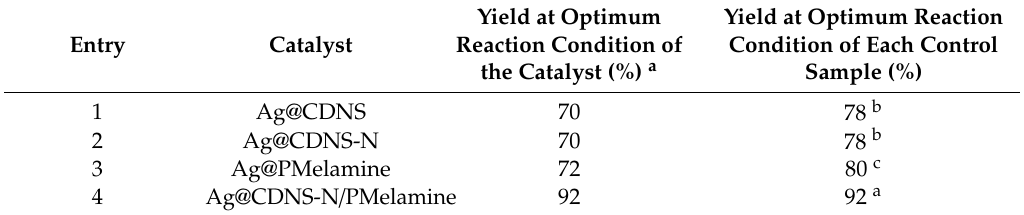
Table 3. Comparison of the catalytic activity of Ag@CDNS-N / PMelamine with some control